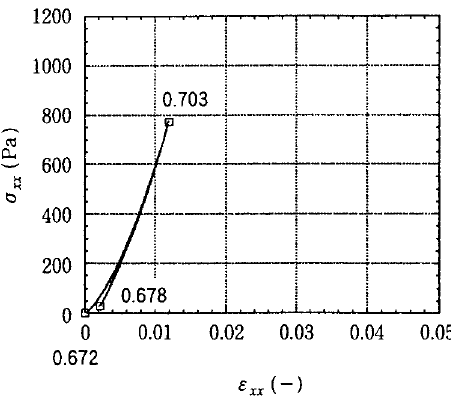
Fig. 7 . Relation between normal stress and strain (simple cubic lattice, F = 30 m w g)